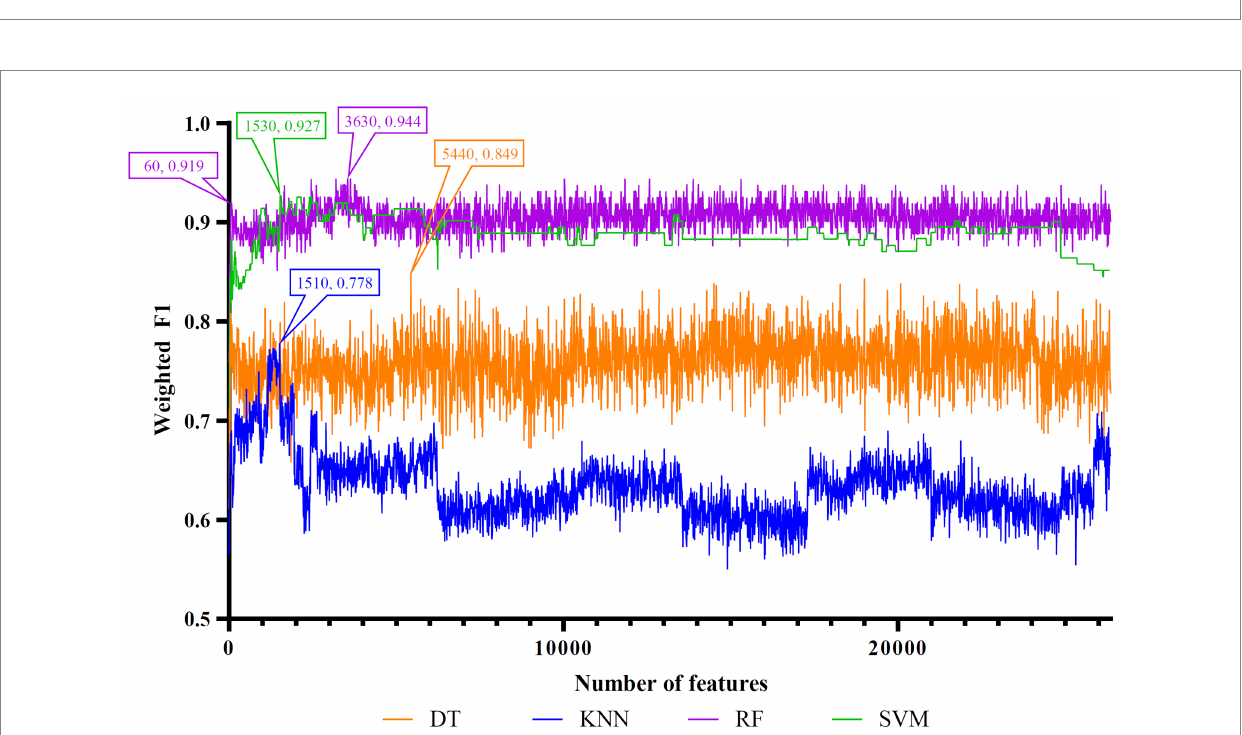
FIGURE 6 IFS curves of four classification algorithms on PFI feature list. DT, KNN, RF, and SVM yielded the highest weighted F1 values of 0.849, 0.778, 0.944, and 0.927 when top 5,440, 1,510, 3,630, and 1,530 features were adopted, respectively. RF can yield quite high performance (weighted F1 = 0.919) when top 60 features were used.